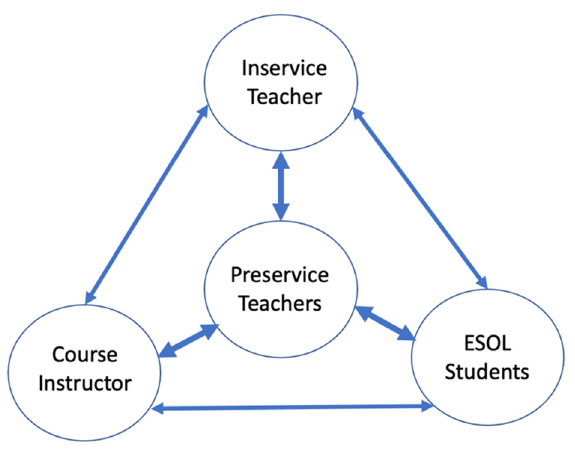
Figure 2. Interaction among the stakeholders.